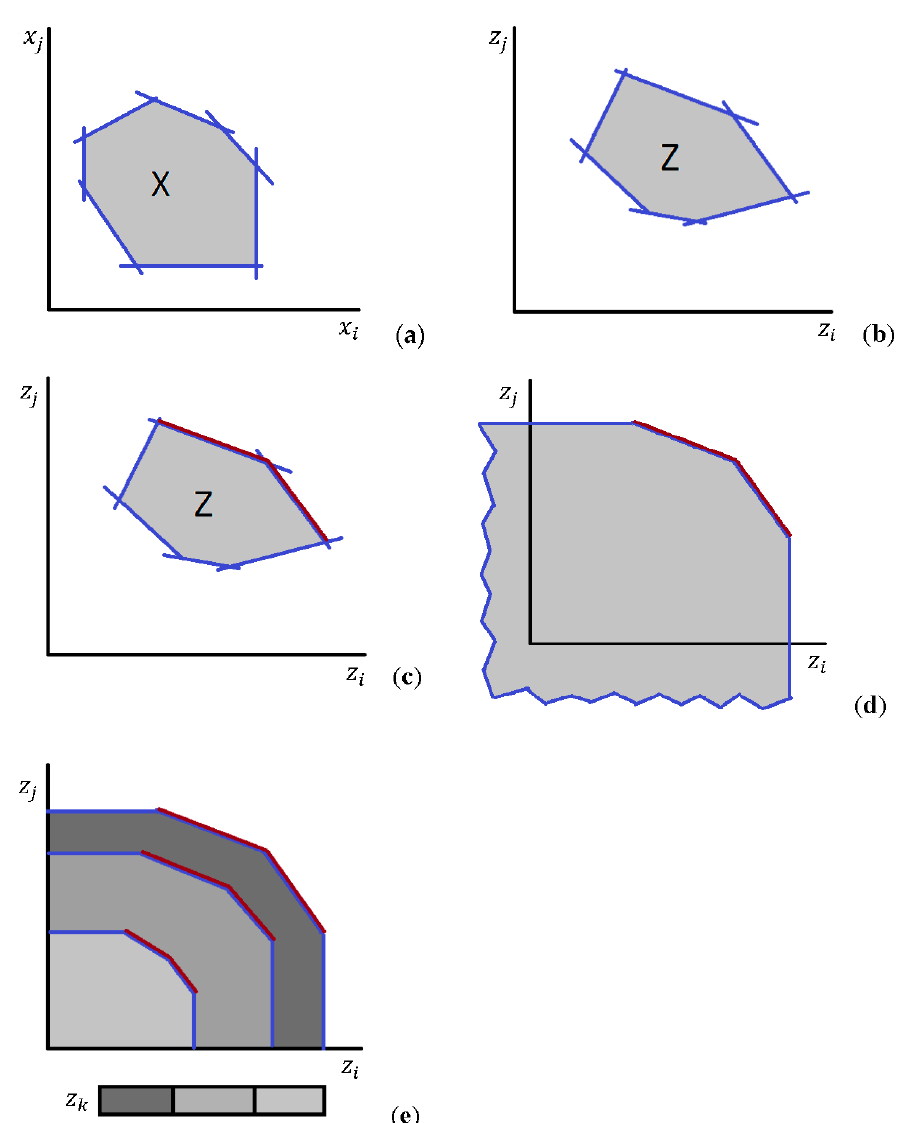
Figure 1. Generation of Pareto frontiers from the Pareto hull. ( a ) Initial convex hull of feasible solutions ( x i , x j ). ( b ) Edgeworth–Pareto hull in the criteria decision space ( z i , z j ). ( c ) Set of efficient solutions in the criteria decision space ( z i , z j ). ( d ) Extension to the Pareto frontier for the efficient solutions set considering two criteria ( z i , z j ) in order to simplify the representation. ( e ) Pareto frontiers representation considering three criteria ( z i , z j , z k